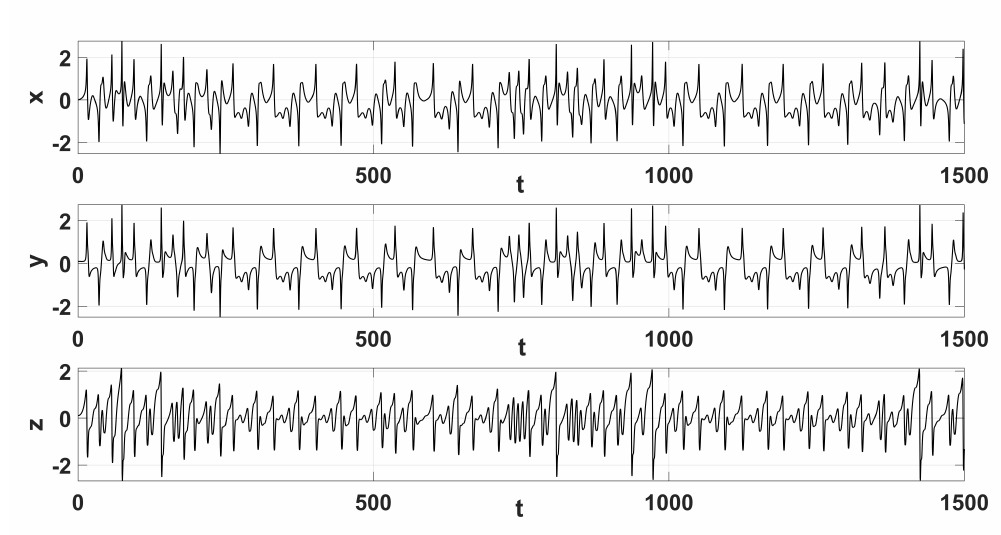
Figure 3. State trajectories of system (1), for a = 0.65 and b = 0.1 and x ( 0 ) = ( 0,0.1,0.1 ) , for 1500 s.